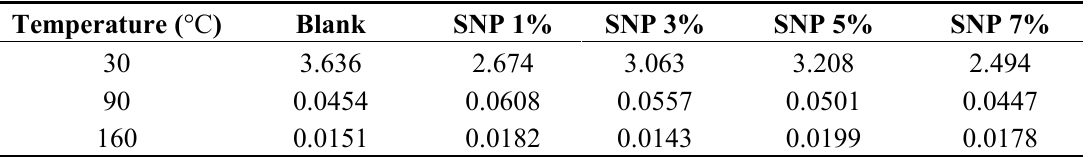
composites (xLCN/SNP) and blank xLCN 2